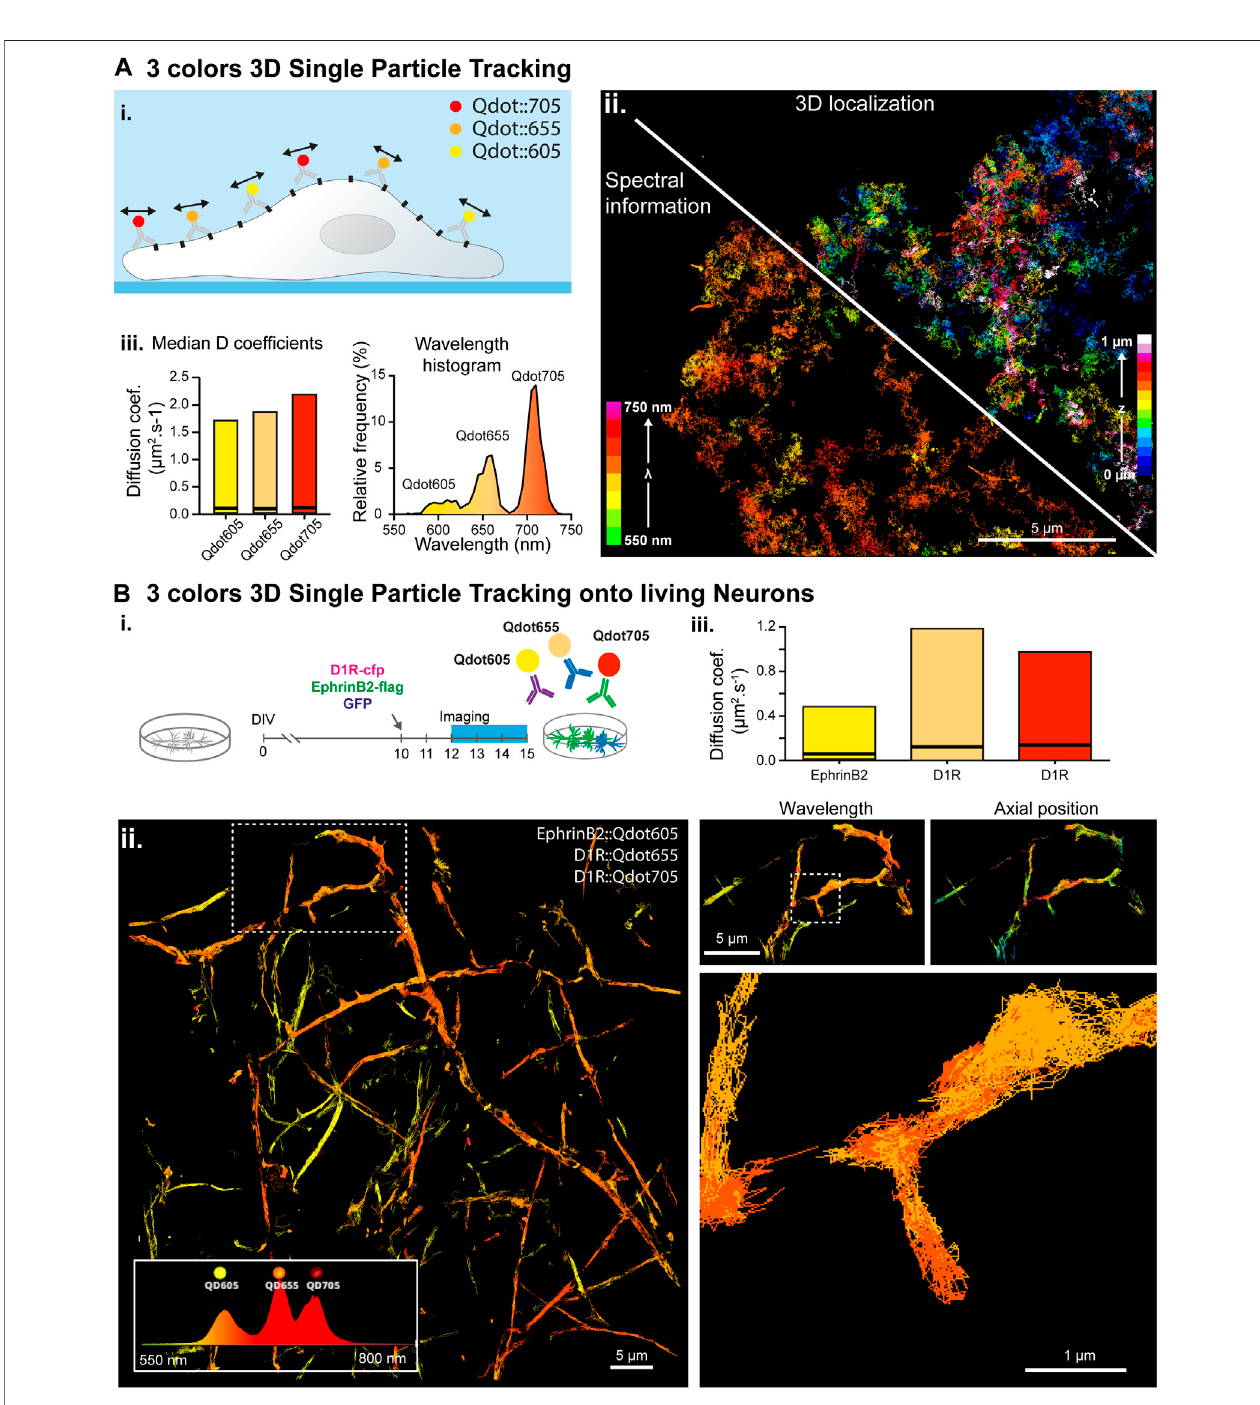
FIGURE 3 | Simultaneous multi-color 3D single molecule tracking. (A) Simultaneous three colors 3D single particle tracking on living COS-7 cells. (i.) Experiment principle: NCAM membrane receptors in a COS cell are labelled with three populations of spectrally different QDots and tracked in 3D over time. (ii.) Reconstructed trajectoriesofthedetectedQdotscolor-codedfortheirdepth(upperrightcorner)orfortheirassignedwavelength(bottomleftcorner). (iii.) Computedmedianandrange of diffusion coef fi cients for each QDots population (left) and histogram of the wavelengths detected during the acquisition revealing the three Qdot populations (right). (B) Simultaneous three colors 3D single particle tracking on living neurons. (i.) Experiment principle: Hippocampal dissociated neurons culture are transfected at DIV-10 with the plasmids coding for D1R-cfp, EphrinD2-Flag and soluble GFP. In between DIV12 and DIV15, expressed D1R-cfp proteins are labelled with two populationsofspectrallydifferentQdots(Qdot655andQdots705)andexpressed EphrinB2- fl agproteinsarelabelledwithQdots605beforebeingimagedandanalyzed byspectrallyinformedlocalizationandtracking. (ii.) Left:ReconstructedtrajectoriesofthethreeQdotspopulations.Right:Successivezoomsofthewhitedottedregions revealing the main and well distinct zones explored by the two receptors (top) and the trajectory of two spectrally different Qdots (Qd655 and Qd705) within a spine (bottom). (iii.) Median and range of diffusion coef fi cients for each of the three different Qdots population, revealing that the two Qdots conjugated to the same receptors (D1R) behave similarly whereas EphrinB2 receptors diffuse